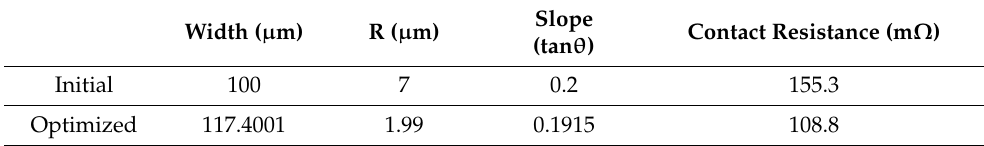
Figure 9. Pressure distributions along contact interface of ( a ) initial and ( b ) optimized CMI. 5. Multiphysics Coupling Simulation and Results In this section, the multiphysics coupling simulation was carried out for both original and optimized CMIs. Furthermore, a cell of 3 × 3 CMI array was simulated to evaluate the thermal performance for an array structure. To conduct the multiphysics simulations, the corresponding settings for individual physics and coupling module should be set up, in- cluding the discretization of geometric model, setting up boundary conditions, and as- signing a coupling path. For electrical simulation, a current source with 1 A amplitude was assigned to the top pad while the bottom surface of the anchor was connected to the ground. The fixed temperature boundary condition with a value of 293.15 K and a heat transfer boundary condition with 7 × 10 6 W/m 2 ·K heat flux were assigned to the bottom surface of the anchor and top pad for thermal simulation, respectively. Rest boundaries